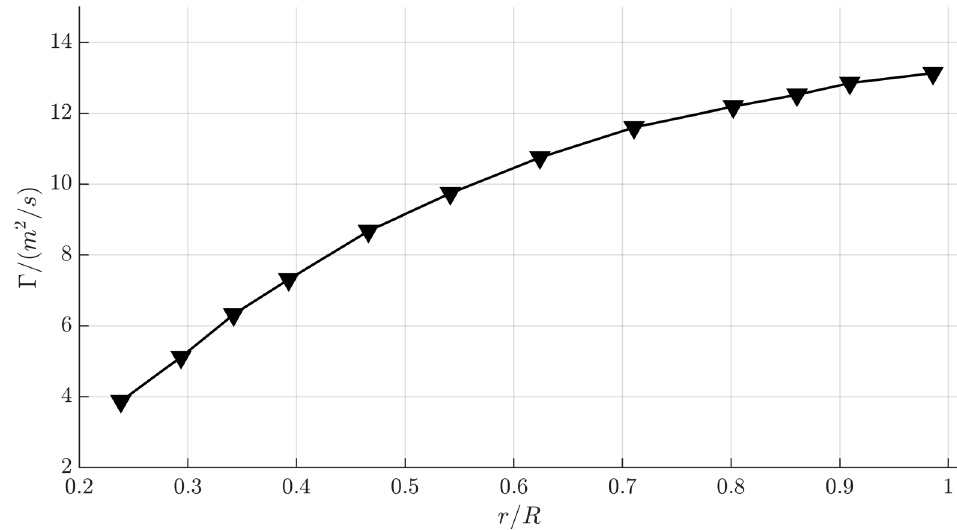
Figure 4. Optimal circulation distribution from Betz theory omitting blade element drags.